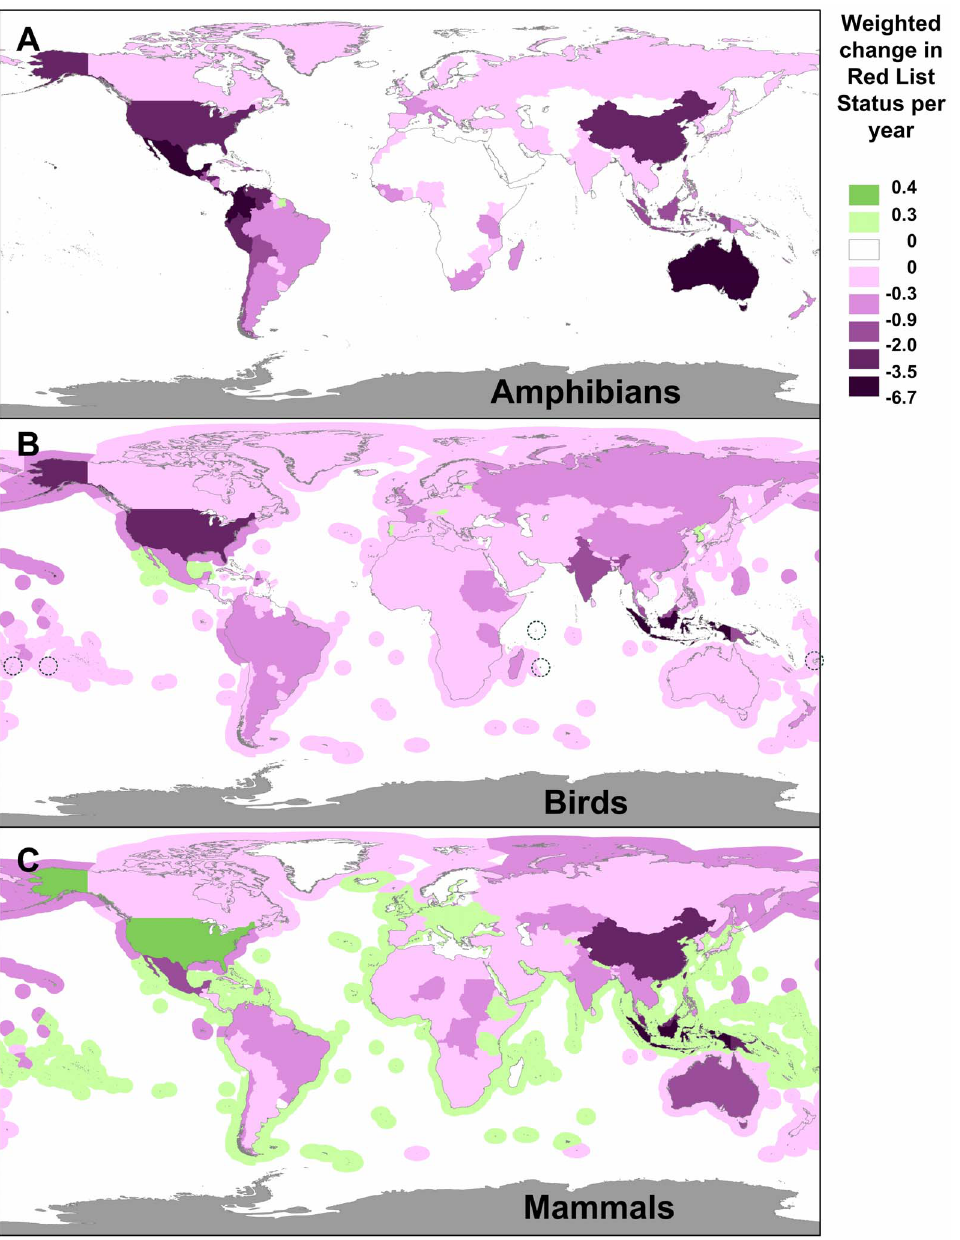
Figure 2. Country contributions towards trends in the global conservation status of amphibians, birds and mammals. Mapped as the variation across countries in the weighted change in Red List status per year, for different taxonomic groups. The same color scale is used across panels (and in Figure 1C) so shades are directly comparable. In (B), the island nations of Tonga, Cook Islands, Seychelles, Mauritius and Fiji are indicated by a dashed